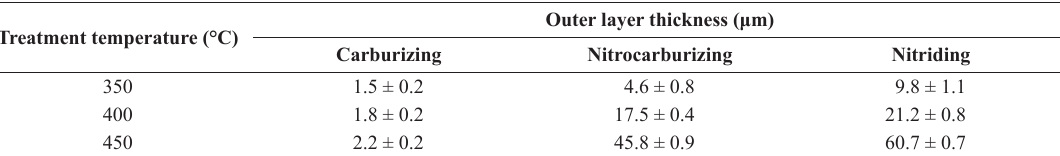
Table 1. Thickness of the outer and diffusion layers obtained for the studied plasma treatment conditions.